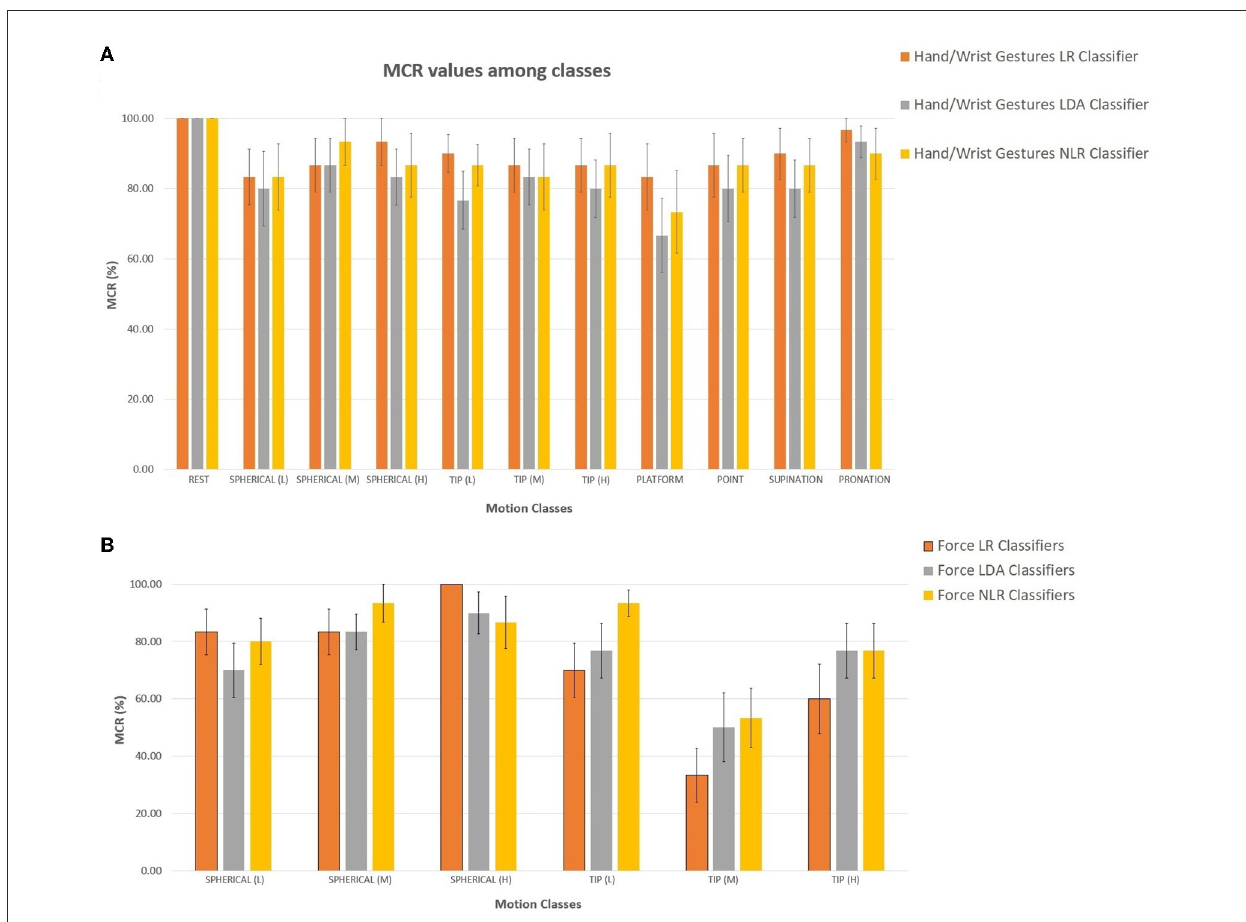
FIGURE6 (A, B) Average MCR percentages calculated for 15 transradial amputees using (A) the LR (in orange), LDA (in gray), and NLR (in yellow) “hand/wrist gestures classifier” (A) and the LR (in orange), LDA (in gray), and NLR (in yellow) force classifiers (B) : the “spherical force classifier” and the “tip force classifier” for the spherical and tip grasp, respectively. The mean MCR percentage was calculated over three repetitions of the reported motion